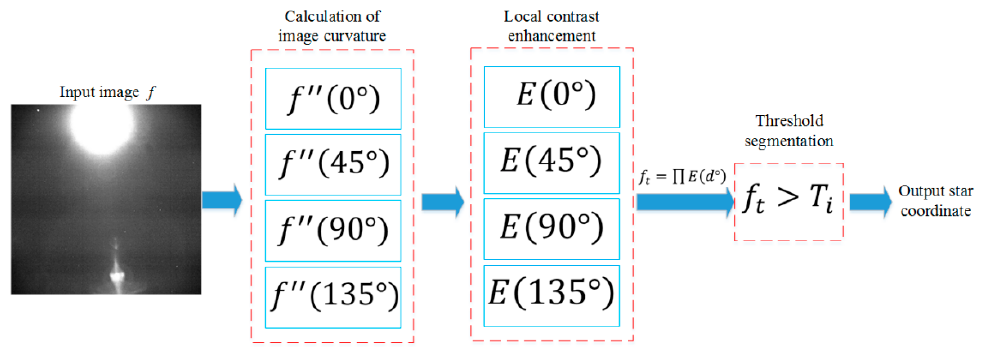
Figure 2. Flow chart of the CMLCM algorithm.